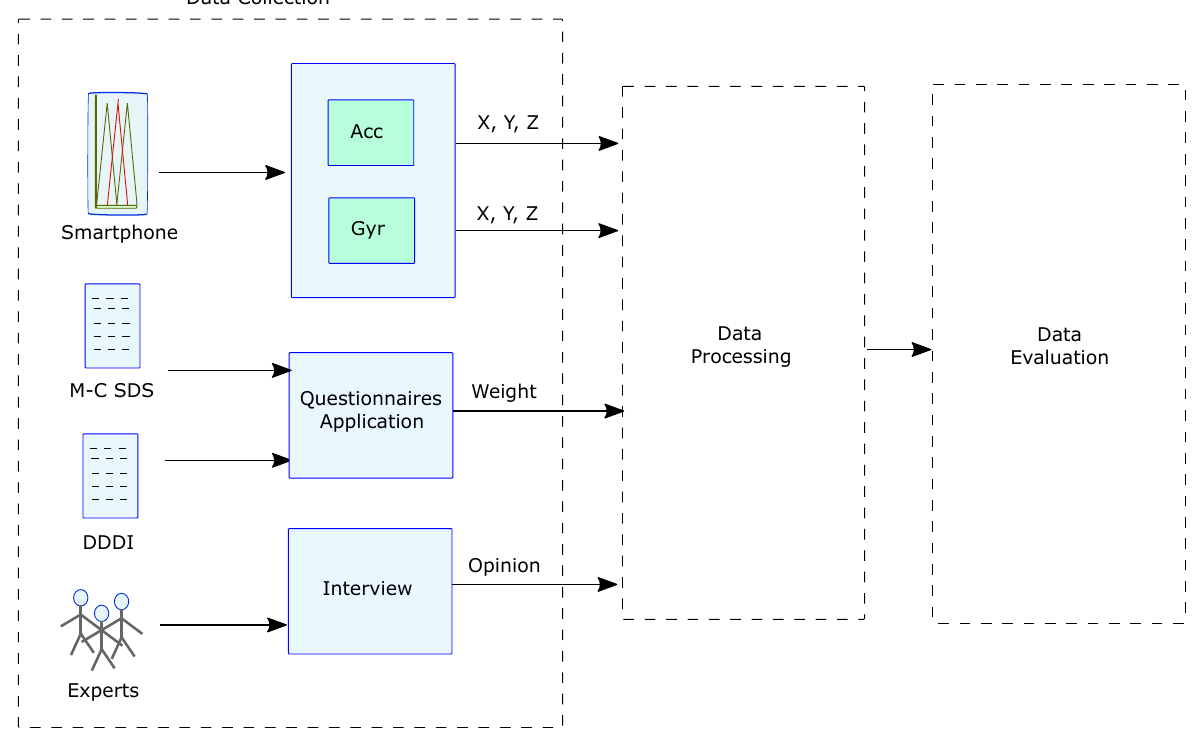
Figure 2. Data collection